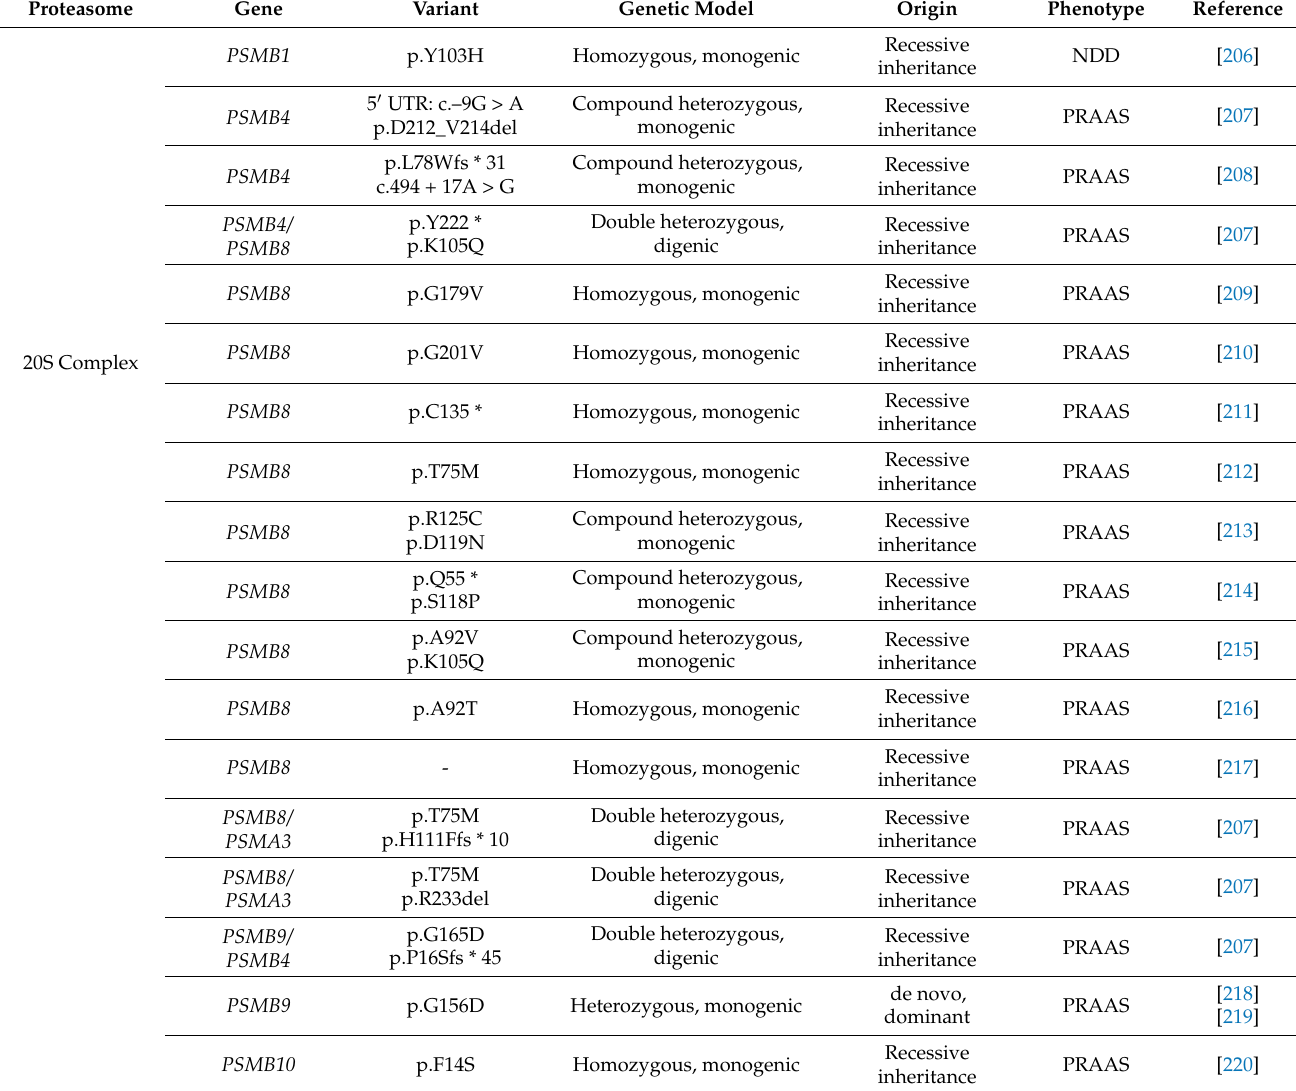
Table 1. Summary of the genetic characteristics and associated clinical phenotypes of the proteasome variants identified so